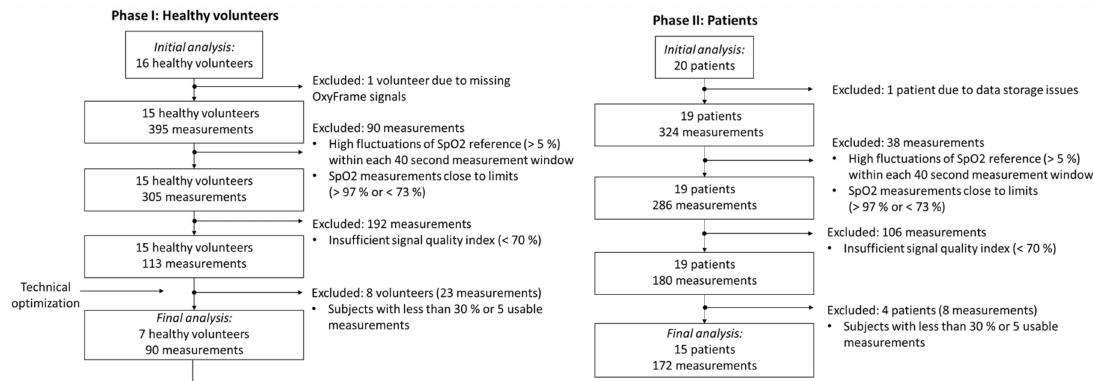
Figure 3. Flow chart of the two-phased study showing the number of measurements remaining for analysis, after applying specific exclusion criteria for both healthy volunteers (in phase I) and patients (in phase II).